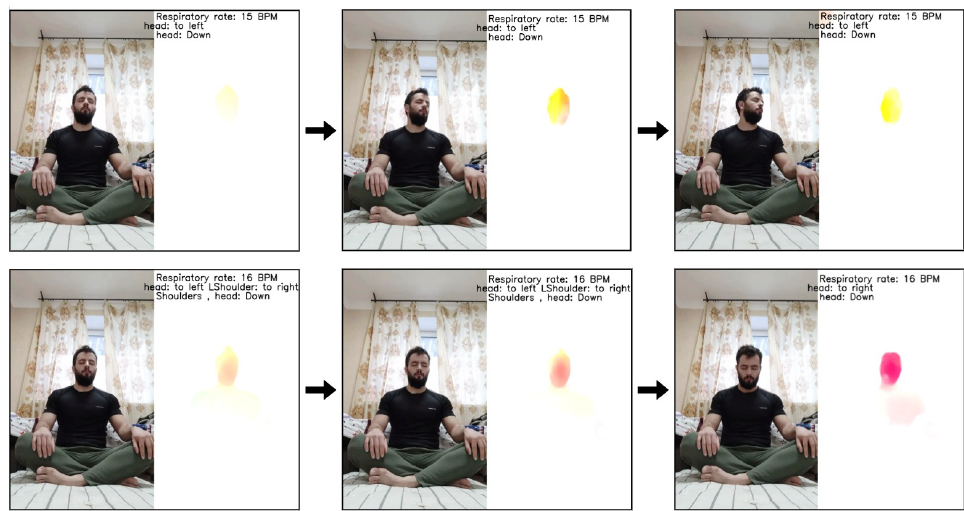
Figure 14. Movement analysis results.